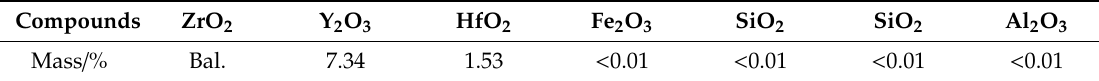
Table 2. Chemical composition of nano-yttria partially stabilized zirconia (YSZ) powder as a surface material.